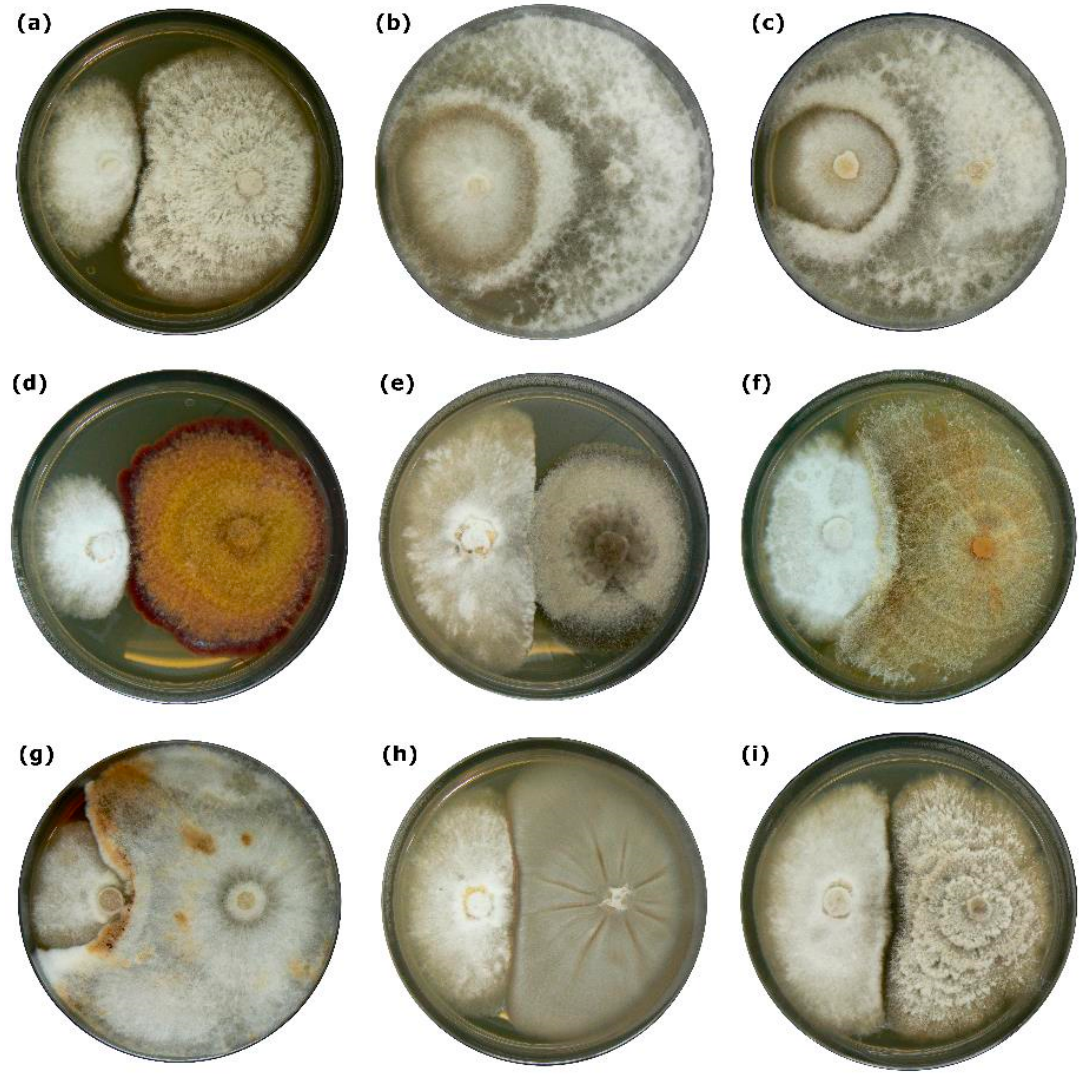
Figure 2. Mycelial interactions after 18 days of co-incubation between the response isolate of E. parasitica (left) and the challenge isolate (right): ( a ) Diaporthe sp.; ( b ) Eutypa sp.; ( c ) Eu. maura ; ( d ) F. avenaceum ; ( e ) N. acerina ; ( f ) Neonectria sp.; ( g ) P. incarnata ; ( h ) Pe. irregularis ; and ( i ) Ph. pustulata . Note: In other replicates different types of interactions could be observed (Table 3).